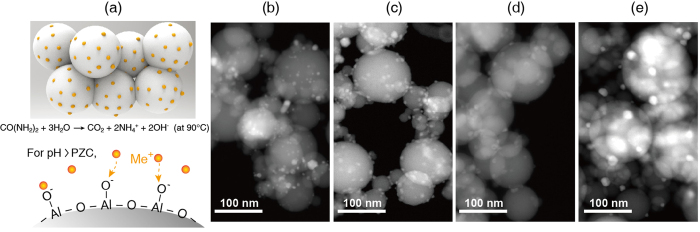
Catalyst synthesis method and synthesized catalyst.(a) Schematic representation of the deposition precipitation method with urea hydrolysis, CO(NH2)2 + 3H2O → CO2 + 2NH4+ + 2OH−, at 90 °C. High-angle annular dark-field TEM images of the as-synthesized catalysts: (b) Pd/Al2O3, (c) Ni/Al2O3, (d) Cu/Al2O3, and (e) Ag/Al2O3. All scale bars correspond to 100 nm.